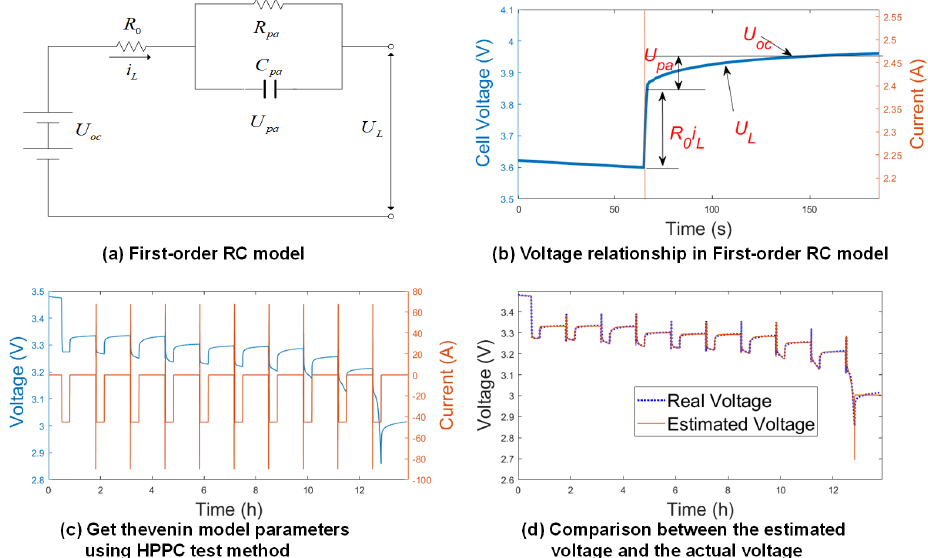
Figure 1. Description of Thevenin model: ( a ) First-order RC model; ( b ) voltage relationship in first- order RC model; ( c ) get Thevenin model parameters using HPPC method; ( d ) comparison between the estimated voltage and the actual